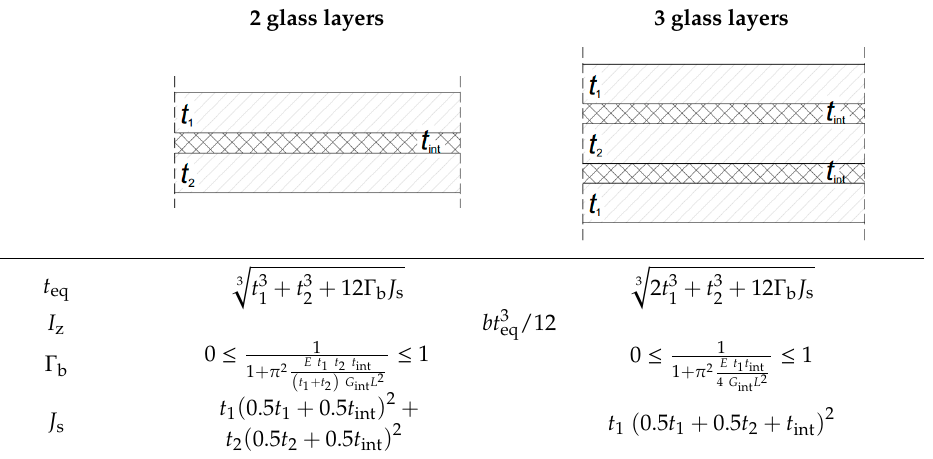
Table 1. Flexural equivalent section properties for laminated glass beams in LTB, according to [25].